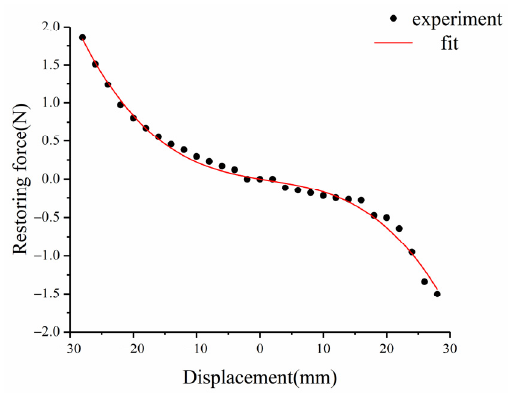
Figure 3. Nonlinear restoring force of linear-arch beam.